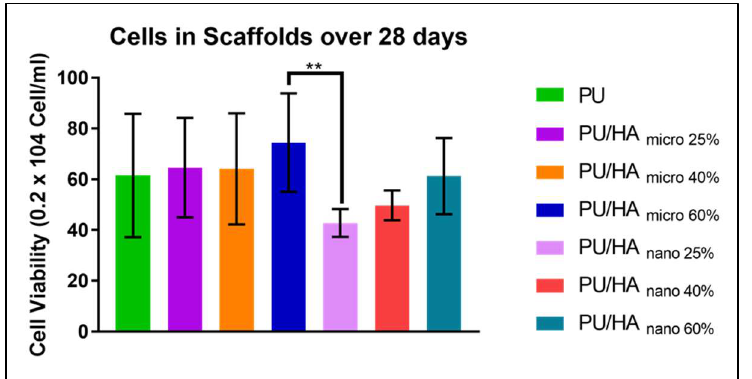
Figure 10. The overall number of metabolically active cells in each scaffold over 28 days. PU/HA micro 60% was significantly higher than PU/HA nano 25%. Differences between two groups were distinguished as statistically significant if p ≤ 0.01 (**).